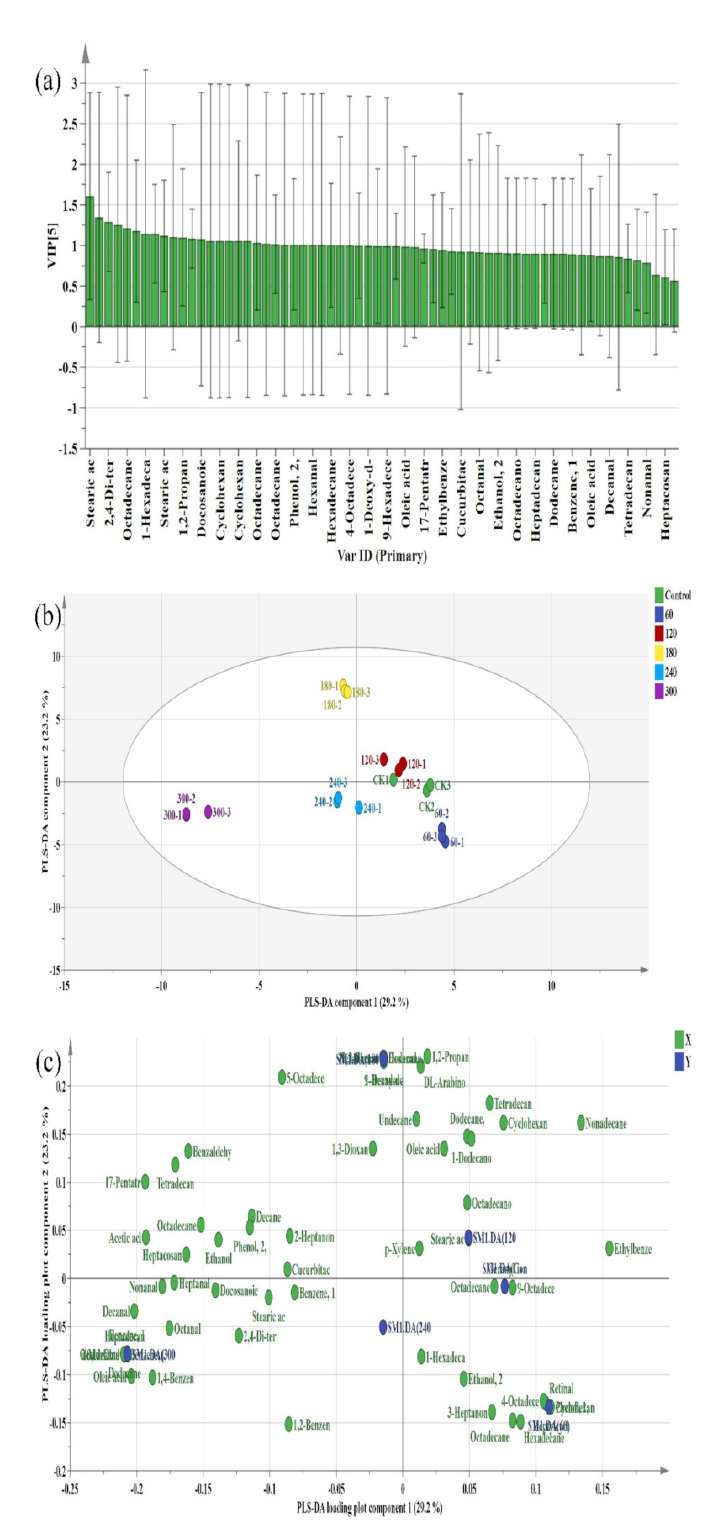
Figure 7. ( a ) The variable importance for the projection (VIP) predictive PLS-DA model of the volatile organic compounds (VOCs); ( b ) PLS-DA score plot showing the variation in the volatile compounds’ fingerprints of HVCP treated EWP; ( c ) PLS-DA loading plot showing the distribution of volatile compounds fingerprints across various HVCP treatment on the EWP. PLS-DA: Partial Least-Square Discriminant Analysis; X: represents the variable; Y: represents the PLS-DA models for the six